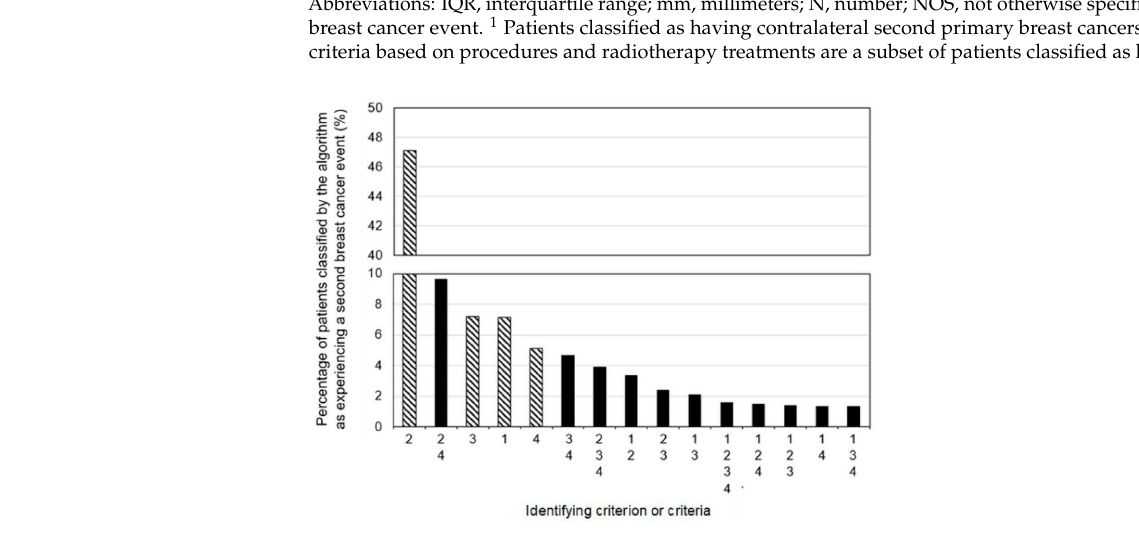
Figure 3. Proportions of patients classified by the algorithm as experiencing a second breast cancer event based on a single criterion (lined bars) or combinations of criteria (solid bars). Criterion/criteria groups are mutually exclusive and collectively exhaustive. All criteria were applied to the entire cohort and could be applied in any order: 1—death from breast cancer; 2—procedure and associated diagnosis; 3—systemic treatment; 4—radiotherapy.